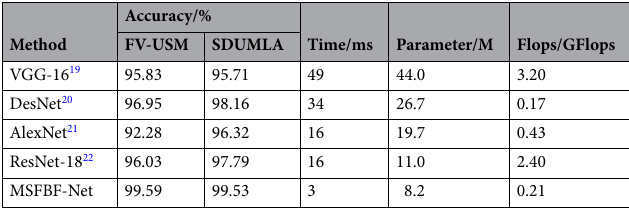
Table 2. Comparison of classic network performance.